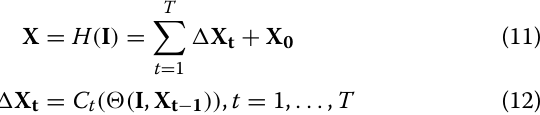
estimates for each image but rather produces estimates for an image using the fully connected layers correspond- ing with its appropriate dataset of origin. This model is essentially training individual regressors for each dataset but shares a common set of feature extractors via the preceding convolutional